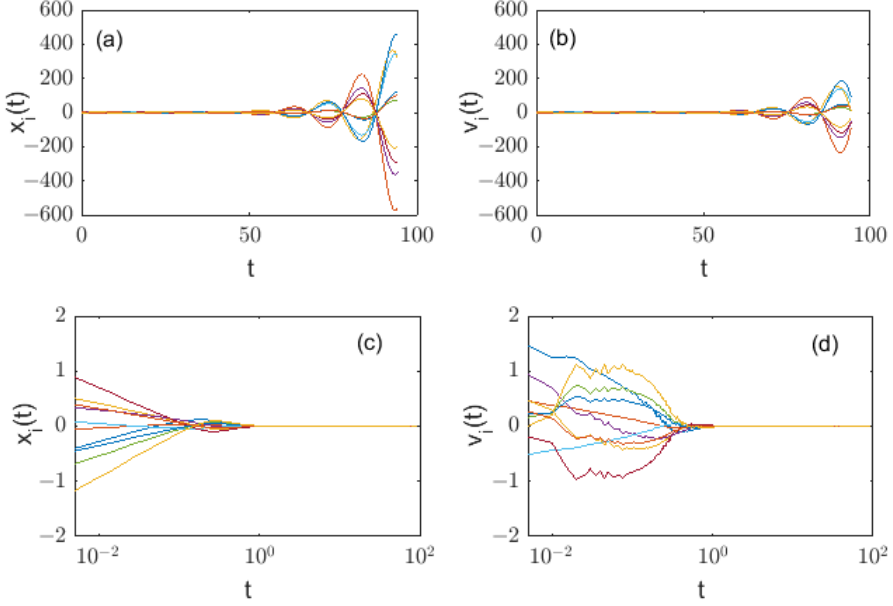
Figure 15. The curves of the position and velocity of each agent as a function of time of FOMAS (2) in the absence of noise ( a , b ) and in the presence of noise ( c , d ) ( 𝑝 = 0.6 ).